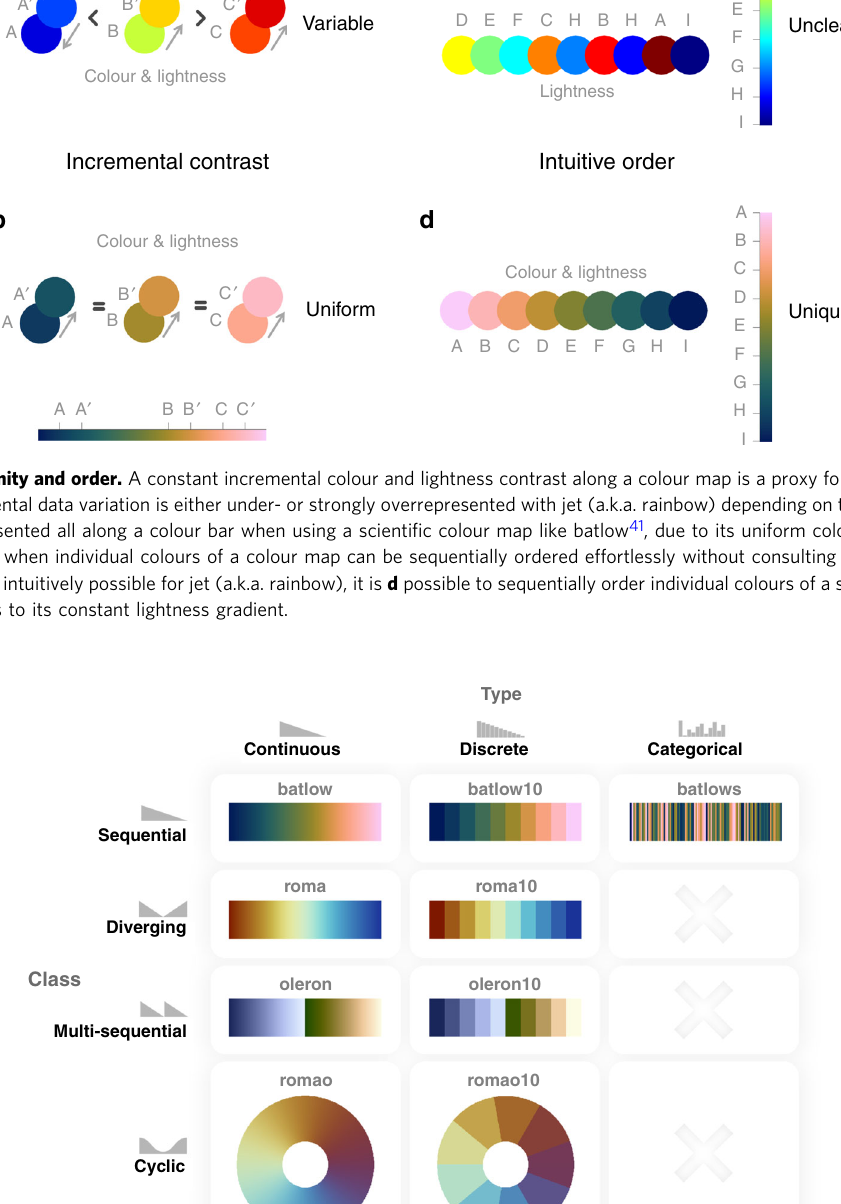
colour bar is included on all fi gures where a colour scale is used, as even the most intuitive colour map could be rendered useless with no colour bar for the reader to refer to. Excluding a colour bar would be equivalent to not including the axis labels and tick marks on the x - or y -axis of a plot. Additionally, attention has to be paid to the lightness (i.e., light or dark) of the background on which the colours are displayed. Background creates contrast, in lightness